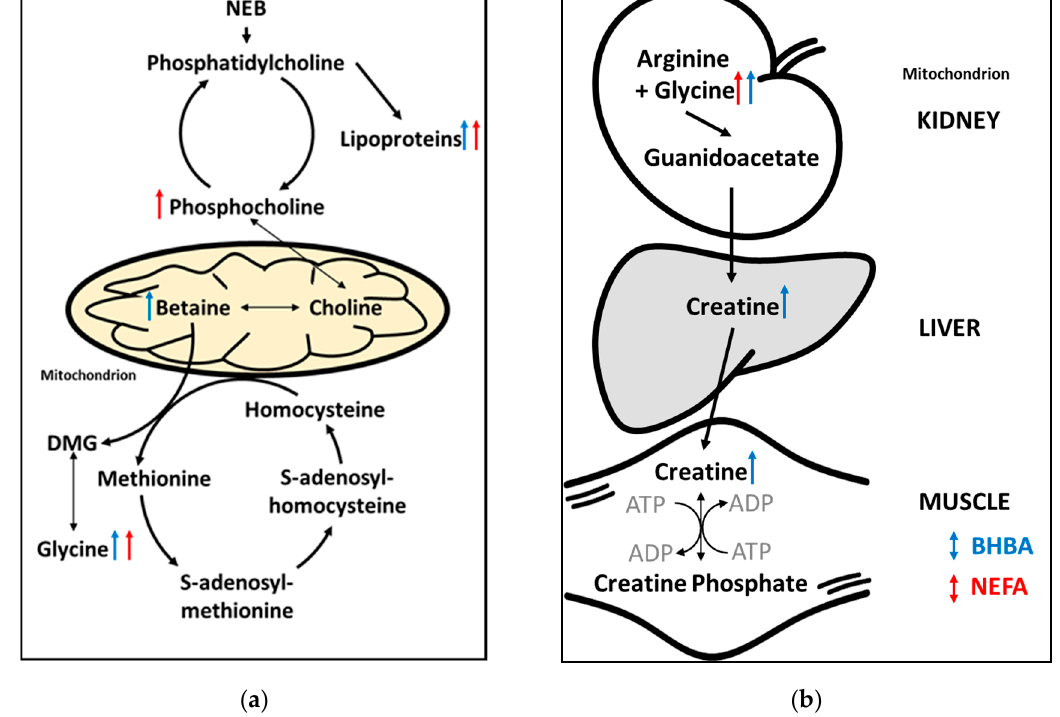
Figure 6. Summary of ( a ) phospholipid and one-carbon/methyl donor metabolism [53,54], and ( b ) creatine metabolism in early lactation dairy cows. Arrows indicate the direction of the relationship between the metabolites identified using untargeted 1 H NMR metabolomics, and reference BHBA (blue) and non-esterified fatty acids (NEFA) (red) concentrations. ADP = adenosine diphosphate; ATP = adenosine triphosphate; DMG = dimethylglycine; NEB = negative energy balance .